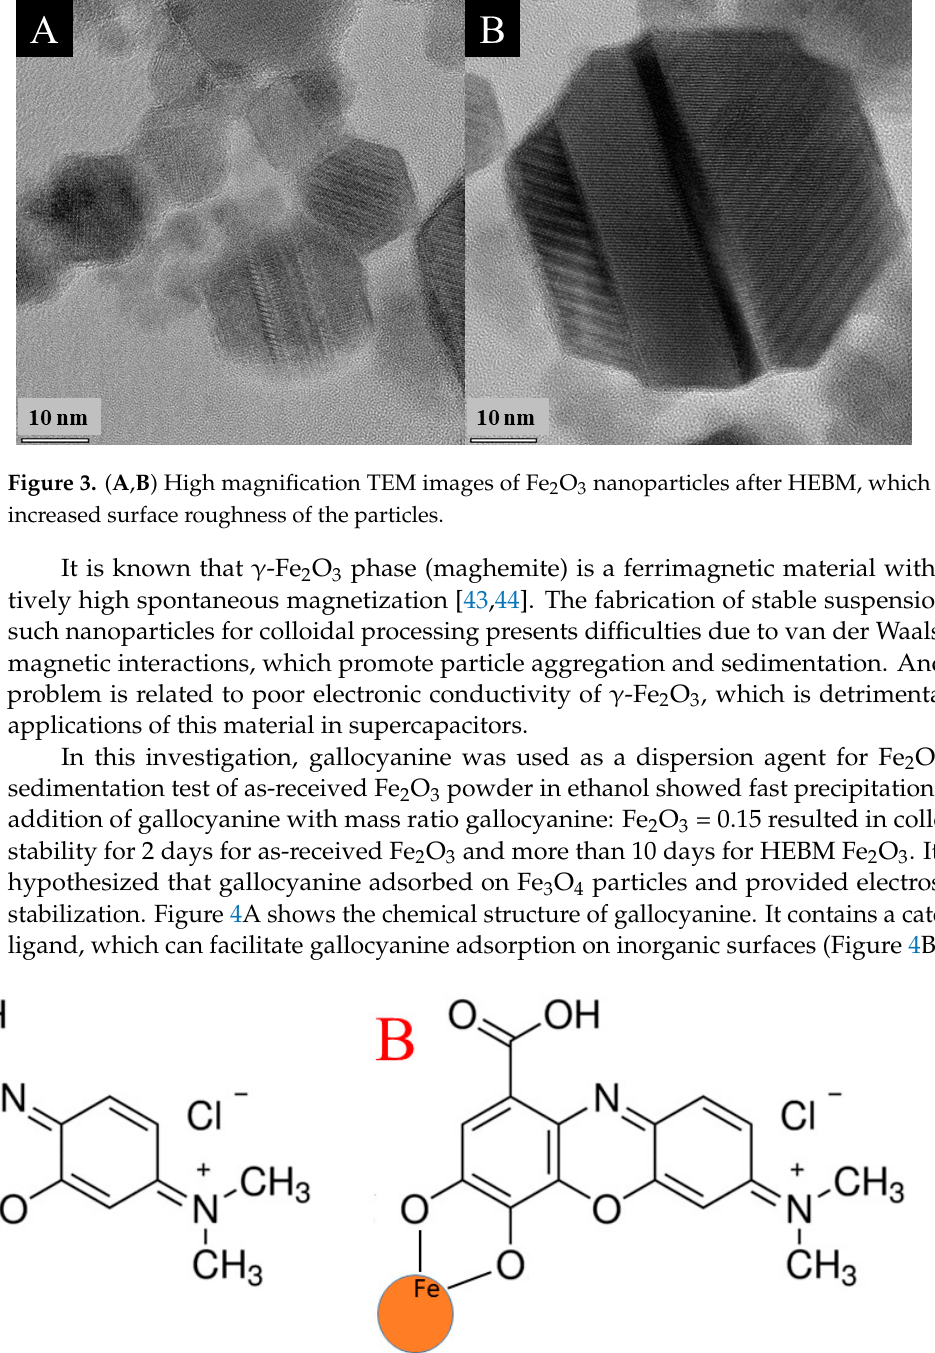
Figure 2. TEM images ( A – D ) at different magnifications for Fe 2 O 3 nanoparticles: ( A , C ) before and ( B , D ) after HEBM. Arrow shows large particle in as-received Fe 2 O 3 .